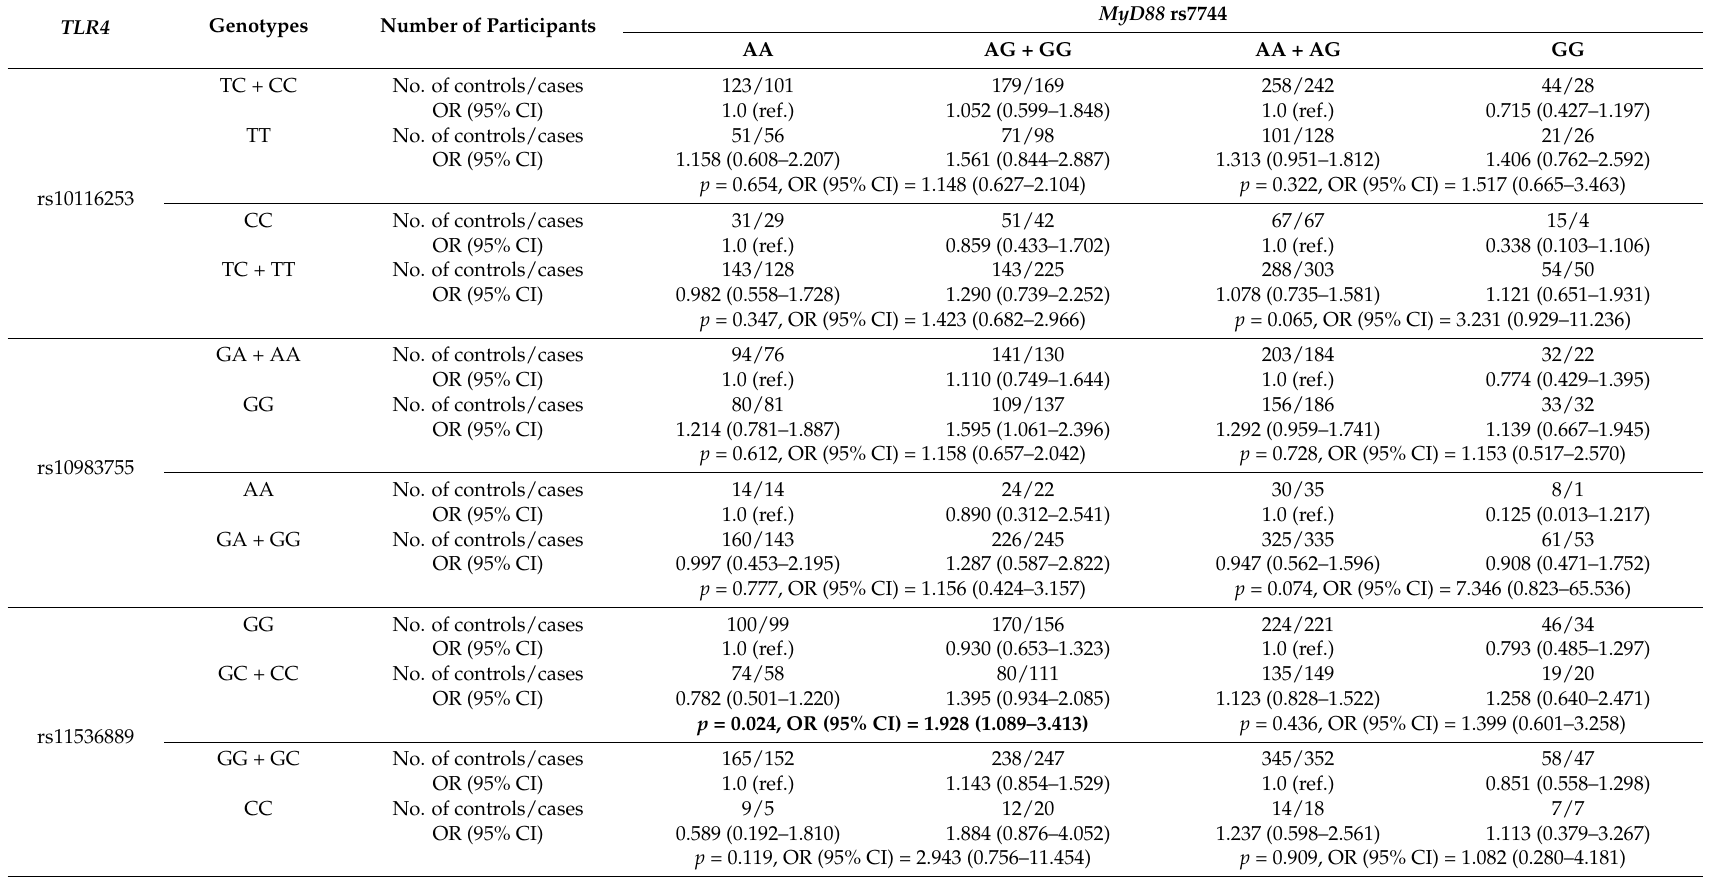
Table 2. Two-way interactions between TLR4 and MyD88 polymorphisms in the risk of